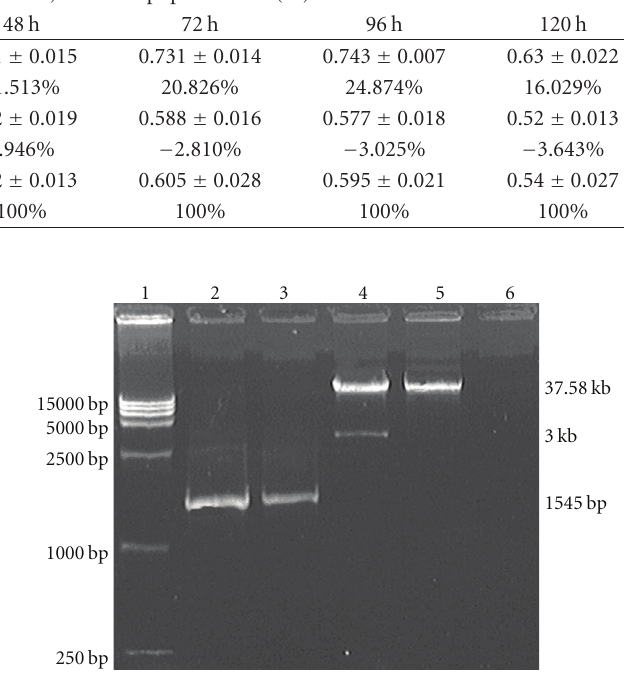
Figure 1: Restrictive analysis of pAd-2A with Pac I and PCR product of target gene. lane 1: Marker DL15000; lane 2: PCR product of positive control (EBV positive B95-8 cell); lane 3: PCR product of pAd-2A; lane 4: pAd-2A/Pac I; lane 5: pAd-2A; lane 6: PCR product of